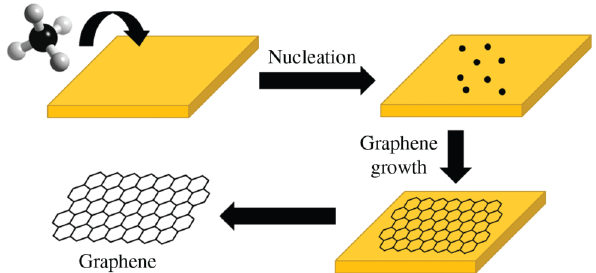
Figure 6: Schematic representation of the graphene production by CVD.